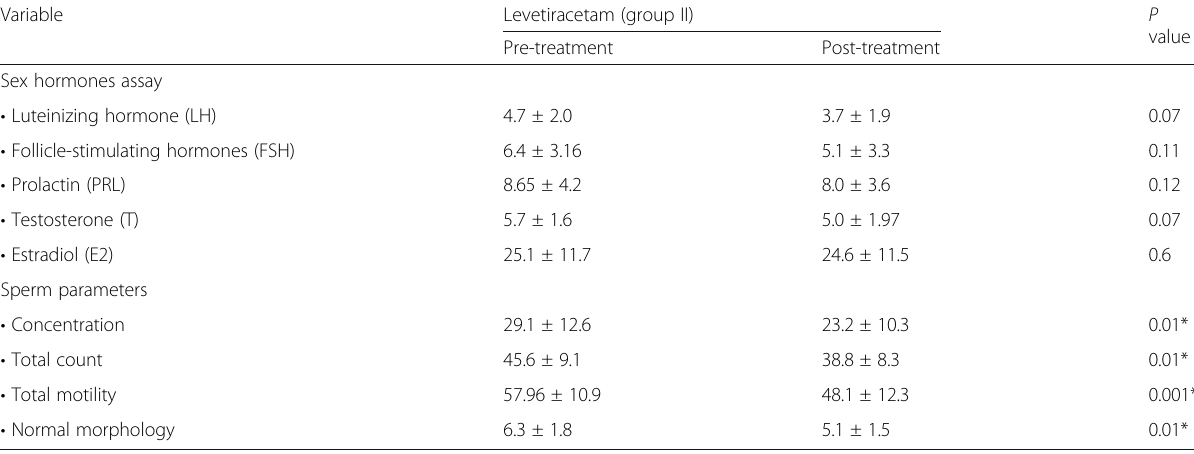
Table 3 Comparison between pre- and post-levetiracetam (group II) treatment regarding sex hormone assay and sperm parameters